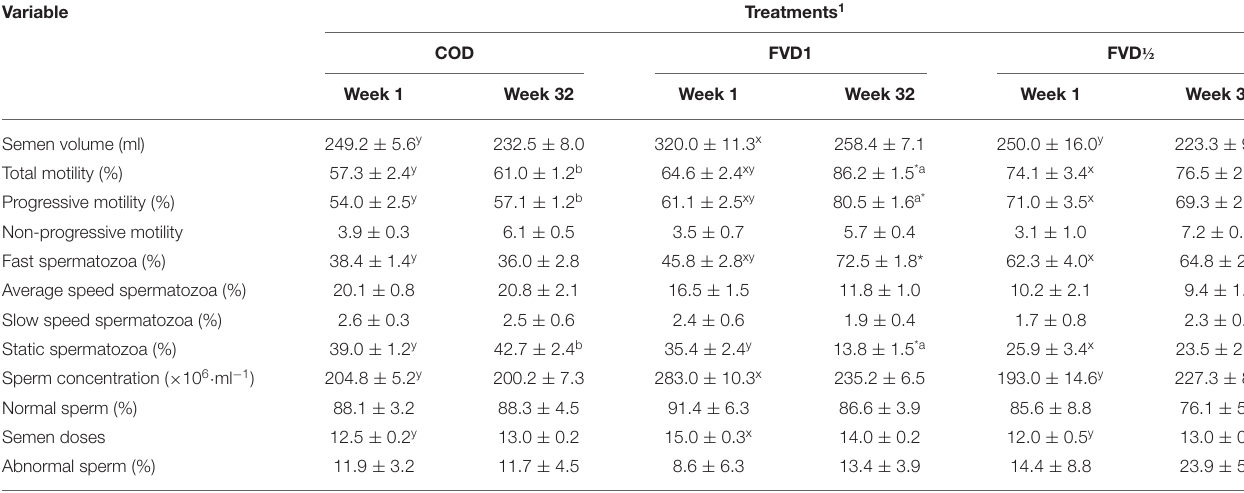
TABLE 4 | Effect of dietary fat-soluble vitamin supplementation on seminal characteristics in boar ejaculates during the experiment (least squares means ± SEM).